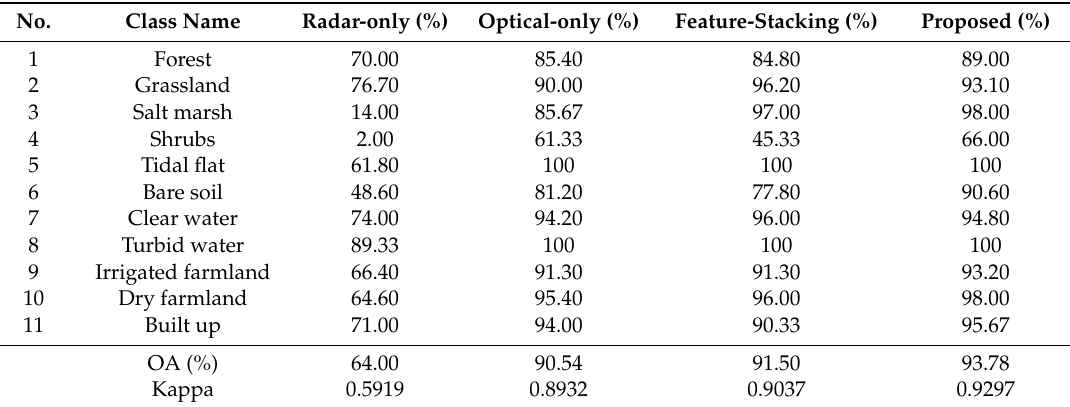
Table 5. Class-level classification